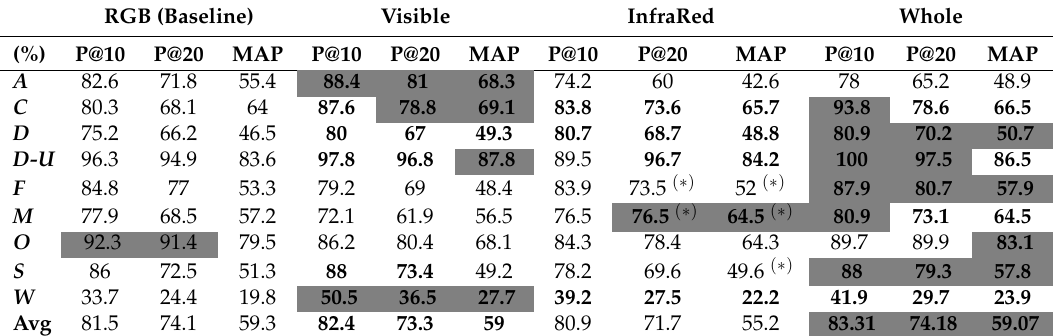
Table 3. Retrieval results for the original RGB images (baseline), the Partial spectral sampling case (Visible and Infra-red ranges), and the Whole spectral sampling case according to the best set of three spectral sensitivity functions for each category. For some categories, the visible range allows better discrimination, and for others, the infrared range is the dominant one. RGB (Baseline) Visible InfraRed